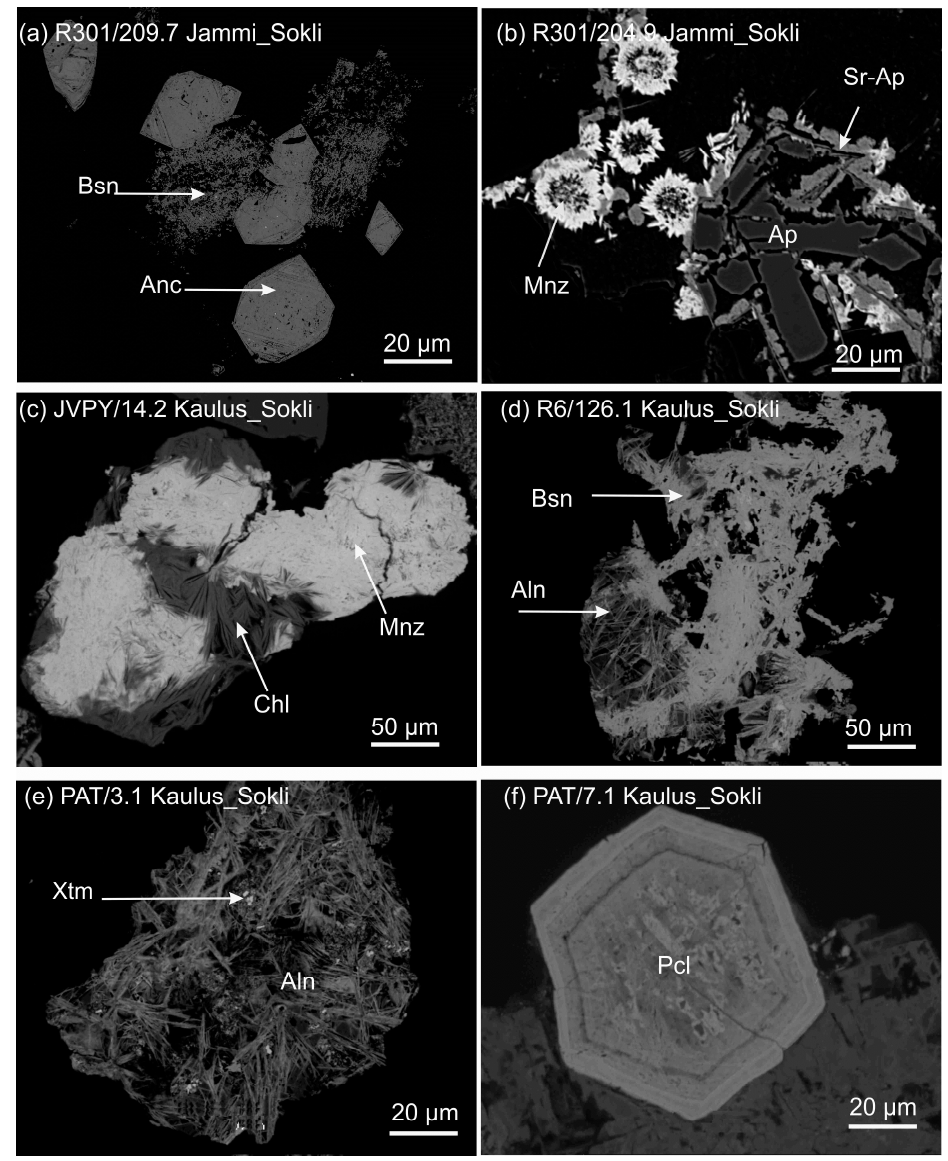
Figure 3. Back-scattered electron images of REE-bearing minerals of Sokli carbonatite; ( a ) Pseudomorphic hexagonal prisms of ancylite (Anc) and bastnäsite (Bsn) occurring as aggregates with ancylite rims or filling the fracture of minerals; ( b ) Circular sunflower-like monazite (Mnz) associated with apatite (Ap); ( c ) Monazite associated with chlorite (Chl); ( d , e ) Acicular to fibrous crystals of allanite(Aln) associated with bastnäsite (Bsn) and xenotime (Xtm); ( f ) Hexagonal pyrochlore (Pcl) crystal.